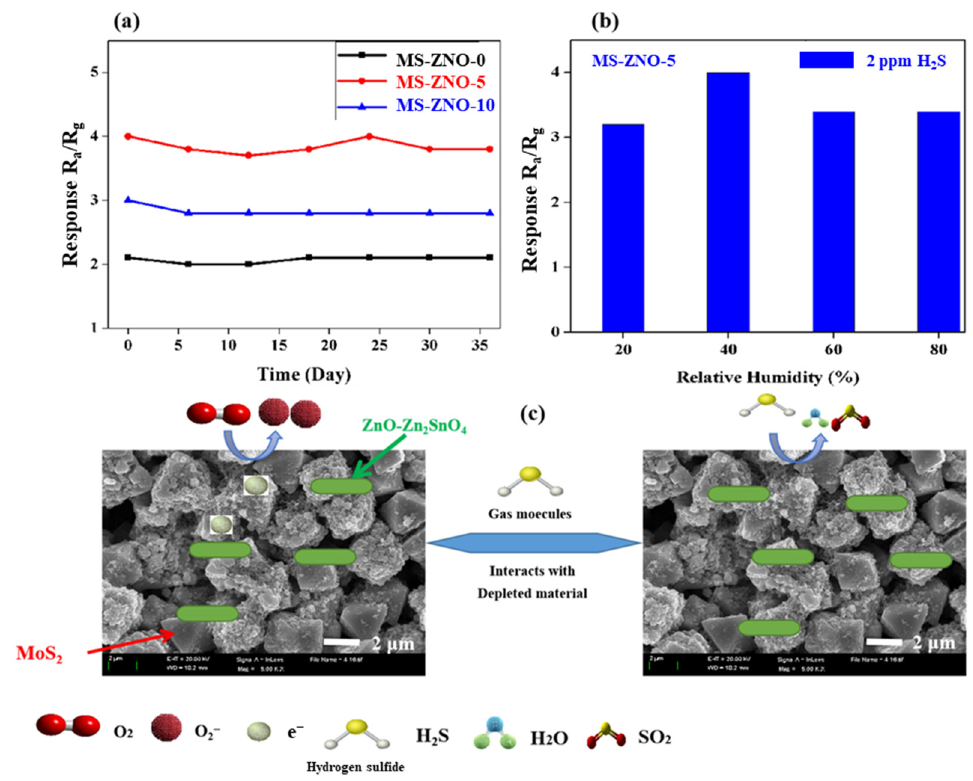
Figure 7. ( a ) The stability graph; ( b ) relationship between response of MS − ZNO − 5 to 2 ppm H 2 S and di ff erent relative humidity at 30 °C; ( c ) diagram of gas sensing mechanism.